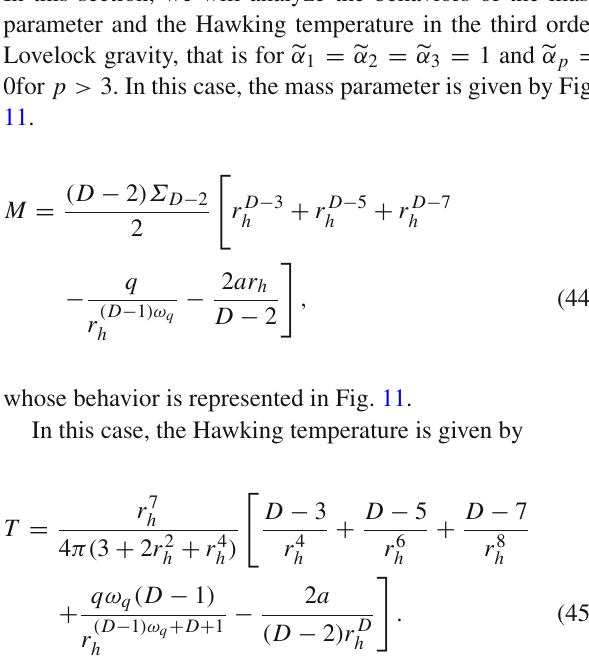
From Fig. 13, we conclude that there are regions which are thermodynamically stables and unstables depending on the dimension of the spacetime.